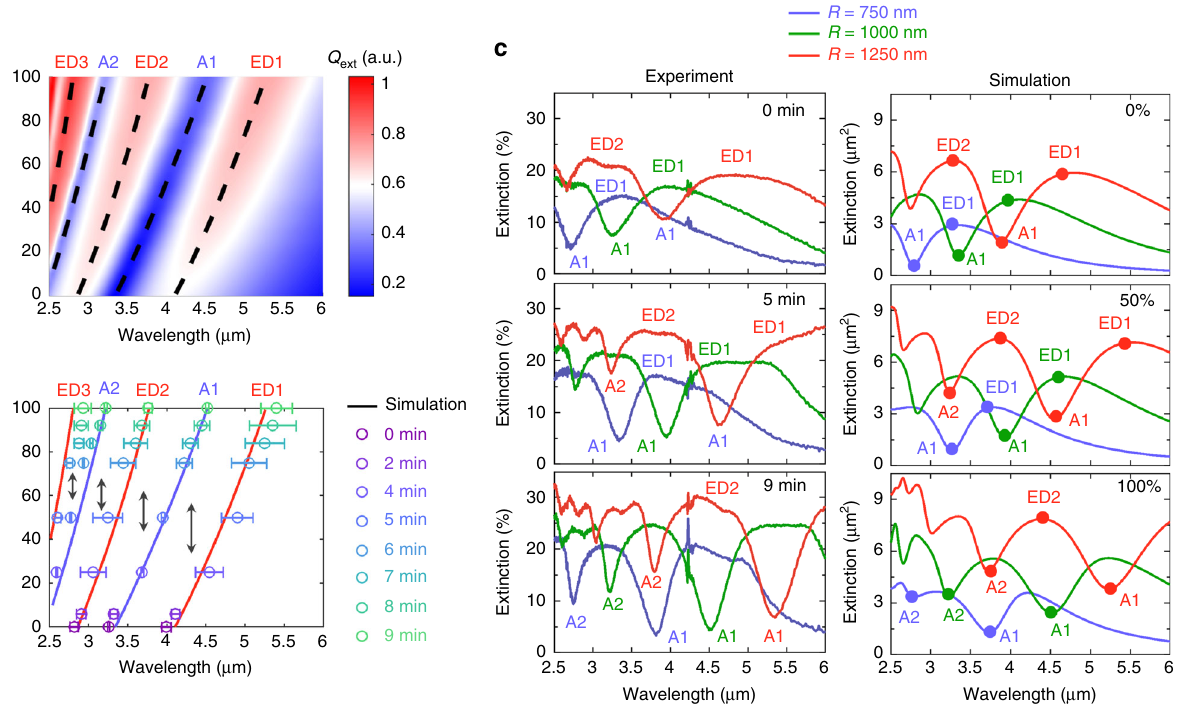
Fig. 4 Multimodal and broadband tuning effects of GST disks with varying crystallinities and radius. a Simulated 2D extinction map of GST disks with a fi xed radius R = 1 μ m and varying crystallinities C . The dashed lines indicate the series of bright and dark states, i.e., ED1, A1, ED2, A2, ED3. b Numerically solved conditions (solid lines) and experimentally measured positions (circles) for different bright and dark states under different crystallinities. c Experimental (left) and simulated (right) extinction spectra of structured GST disks with different disk radius. Mode shifting effects such as from ED to A1 or from A1 to A2 are demonstrated in a broadband region over 1 μ